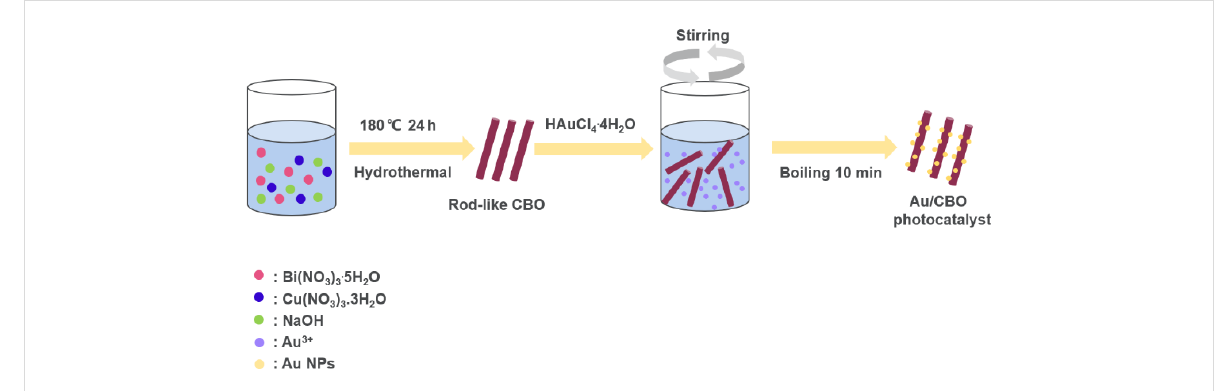
Figure 1: Synthesis of Au/CBO composite.